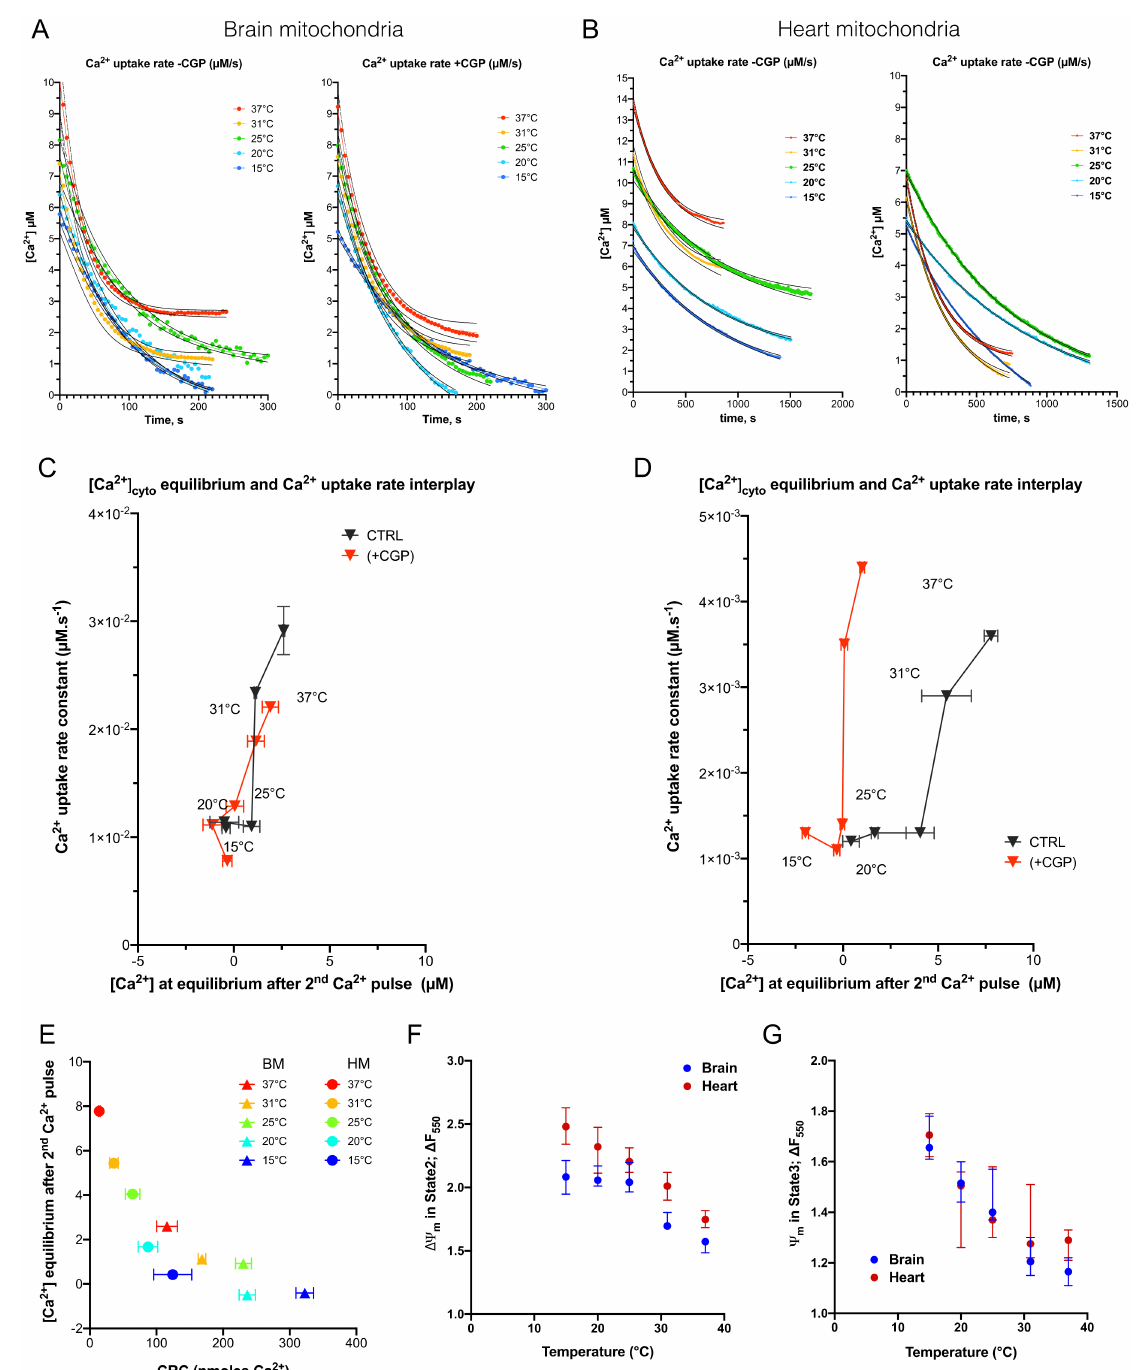
Figure 5. The dependance of Ca 2+ uptake rate and steady-state [Ca 2+ ] concentration in mitochondria on the temperature. ( A ), [Ca 2+ ] over time at each temperature presented as the Calcium Green 5N fluorescence decay after the second pulse of Ca 2+ of each CRC assay. Values were normalized by the peak value at origin of each curve. Experiments conducted with or without NCLX inhibitor (CGP). Dotted lines represent logistic regression IC95%. ( B ), as A for heart mitochondria. ( C , D ), biplots represent interplay between [Ca 2+ ] at equilibrium and Ca 2+ uptake rate in mitochondria of brain and heart, respectively. Data were extracted from Figure 5A,B. Data are expressed as mean ± SEM ( E ) , Correlation between steady-state [Ca 2+ ] concentration and CRC values in BM and HM. Ψ m estimation was figured out in either state 2 respiration ( F ) or state 3 respiration ( G ) in both brain and heart mitochondria at different temperatures as reported in the M and M